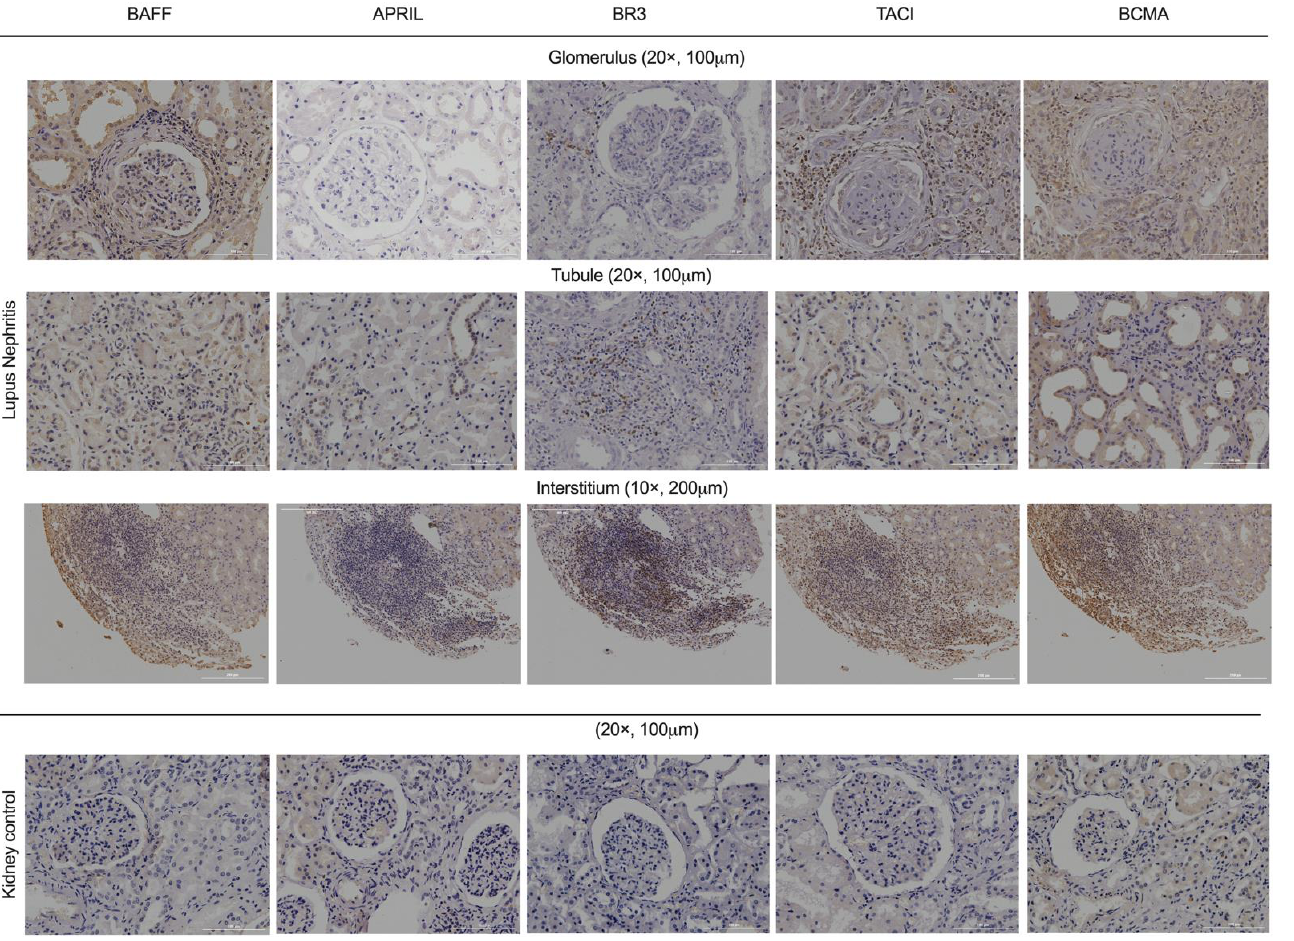
Figure 1. BAFF system expression in lupus nephritis tissues and kidney controls. Glomerular, tubular, and interstitial zones have a positive stain directed to BAFF system members. BR3 and TACI show more stains in the interstitial infiltration. Thus, APRIL was the lowest. The inflammatory cells in the interstitium could simulate an ectopic germinal center. Kidney control tissues did not show expression of BAFF, APRIL, or their receptors. BAFF: B-cells activating factor, APRIL: A proliferation- inducing ligand, BR3: BAFF receptor, TACI: Transmembrane activator and CALM interactor, BCMA: B-cell maturation